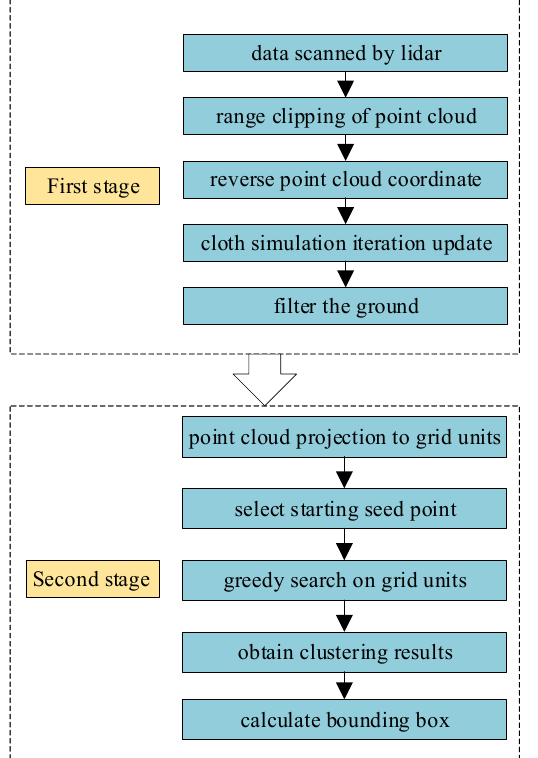
Figure 1. The main steps of the detection method based on cloth simulation and greedy search.